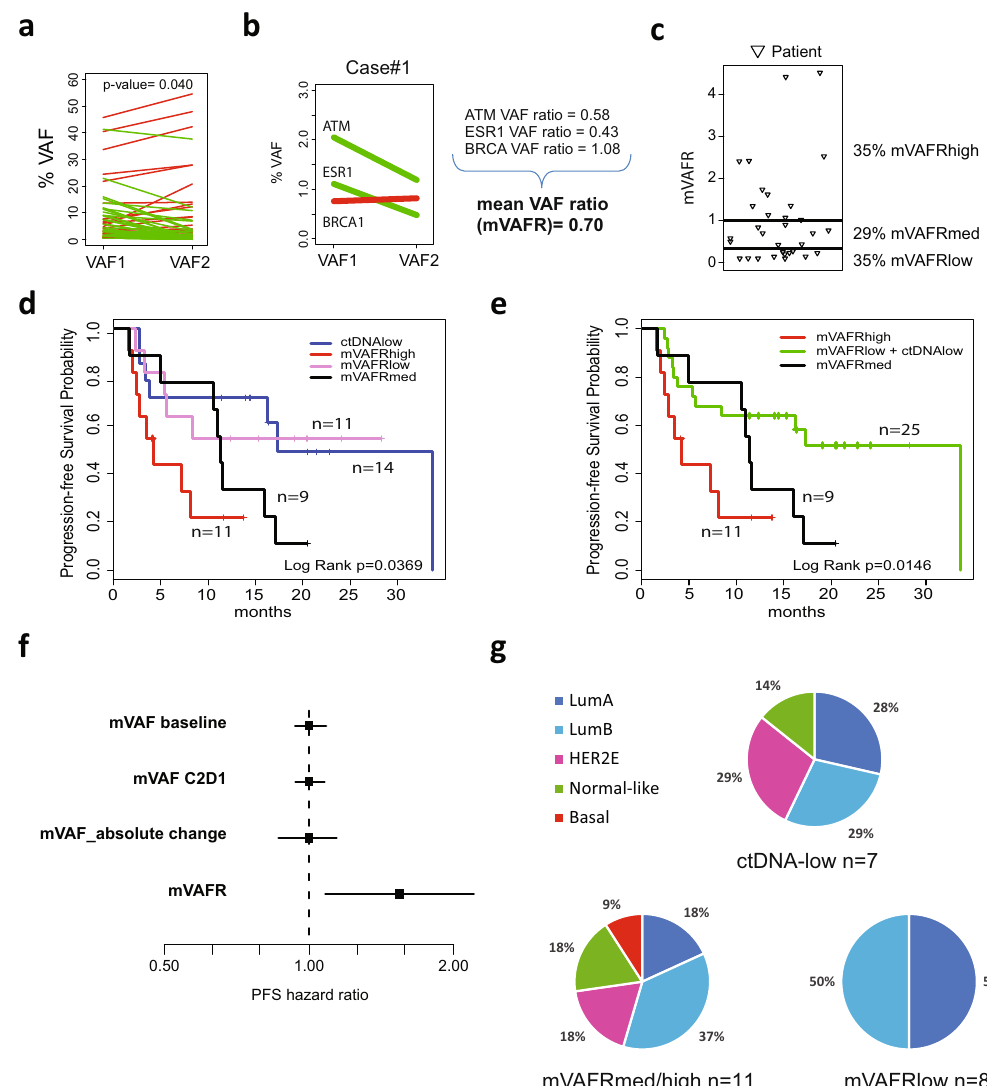
Fig. 2 ctDNA dynamics and survival outcome. a VAF changes of 79 detected mutations from baseline to C2D1. p -value was calculated with Wilcoxon rank sum test. b Illustration of a case and its mVAFR. c Distribution plot of patients with mVAFR-low (mVAFR of ≤ 0.3), mVAFR-medium [mVAFRmed] (mVAFR of 0.31 – 0.99) and mVAFR-high (mVAFR of ≥ 1.0). d PFS based on ctDNA dynamics. e PFS based on ctDNA dynamics after combining the VAFR-low and ctDNA-low groups. f PFS hazard ratio forest plots across 4 different methods of assessing mVAF as a continuous variable: mVAF baseline, mVAF at C2D1, absolute change of mVAF between baseline and C2D1 and mVAFR of all mutations with a VAF ≥ 0.4 at baseline or C2D1. g Distribution of the intrinsic subtypes in the mVAFR-low group ( n = 4 Luminal A [LumA], n = 4 Luminal B [LumB], n = 3 non- available tissue [NA]), mVAFR-medium/high group ( n = 2 LumA, n = 4 LumB, n = 2 HER2-Enriched [HER2E], n = 2 Normal-like, n = 1 Basal-like, n = 9 NA) and ctDNA-low group ( n = 2 LumA, n = 2 LumB, n = 2 HER2E, n = 2 Normal-like, n = 7